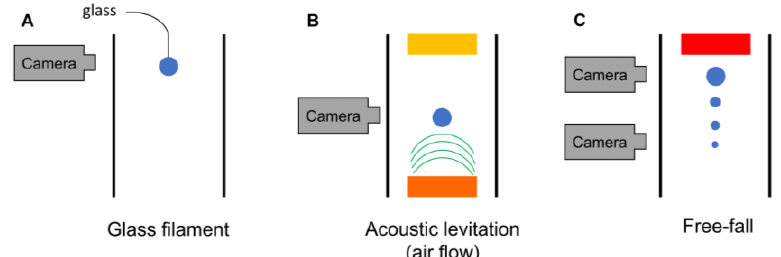
Figure 2. Schematic illustration of single droplet drying methods: ( A ) Glass filament, ( B ) Acoustic levitation or levitation by air flow, where both a transducer (orange) and a reflector (yellow) are needed to obtain acoustic waves (green), ( C ) Free-fall method, where a monodisperse droplet generator (red) produces the droplet (modified from de Souza Lima et al. [1]). Table 1. Comparison of single droplet drying methods: Principles, information, (dis)advantage(s), and similarity to pharmaceutical applications [1,15,17].